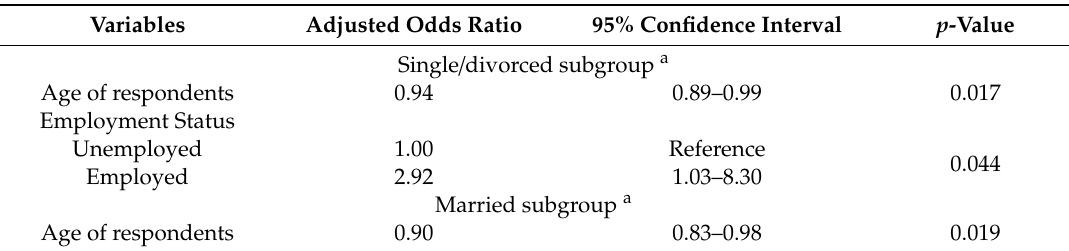
Table 4. Multiple logistic regression analysis of the variables associated with sexual activity among the patients on MMT and single / divorced subgroup ( n = 142) or married subgroup ( n =